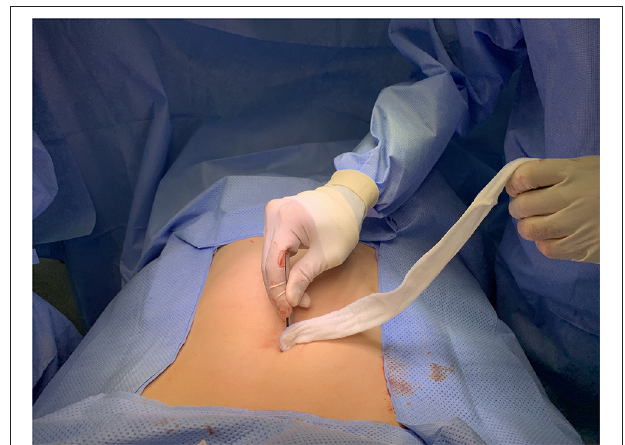
FIGURE 1 | Wound irrigation using wet gauze after closure of the fascia layer. After gentle wound irrigation with wet gauze, dry gauze was used to dry the